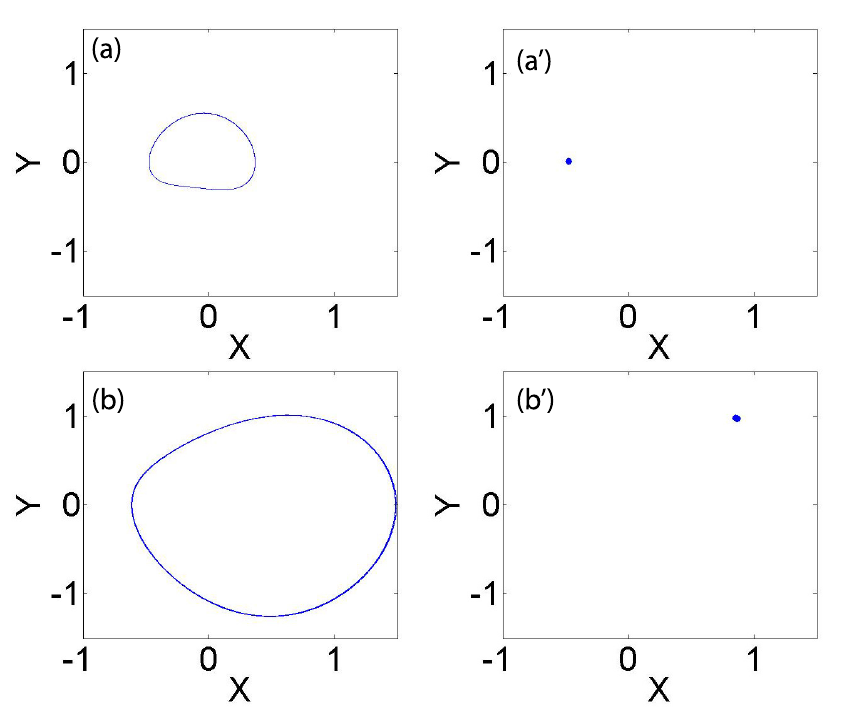
Figure 5. Numerical plots of the vertically excited parametric pendulum with a torque (Equation (4)) with parameter values α = 0.15, γ = 1, ω = 1, respectively. ( a , b ) Trajectories, ( a’ , b’ ) stroboscopic maps. The effect of the torque can also be observed, since ν = 0 in ( a , a’ ), and ν = 0.6 in ( b , b’ ). X and Y represent angular displacement and velocity,